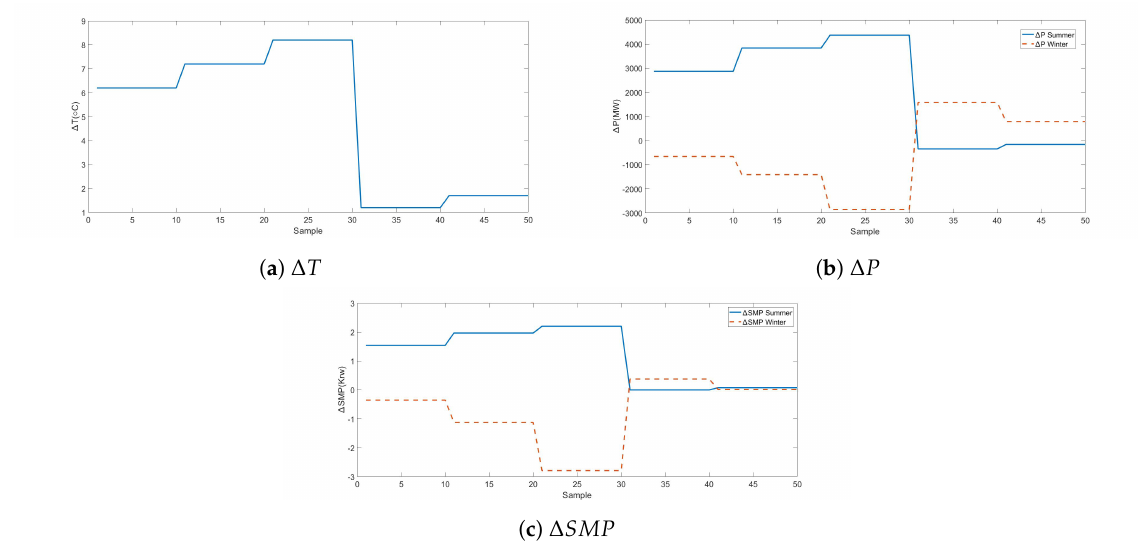
Figure 18. Incremental relationship of ∆ T , ∆ P , ∆ SMP